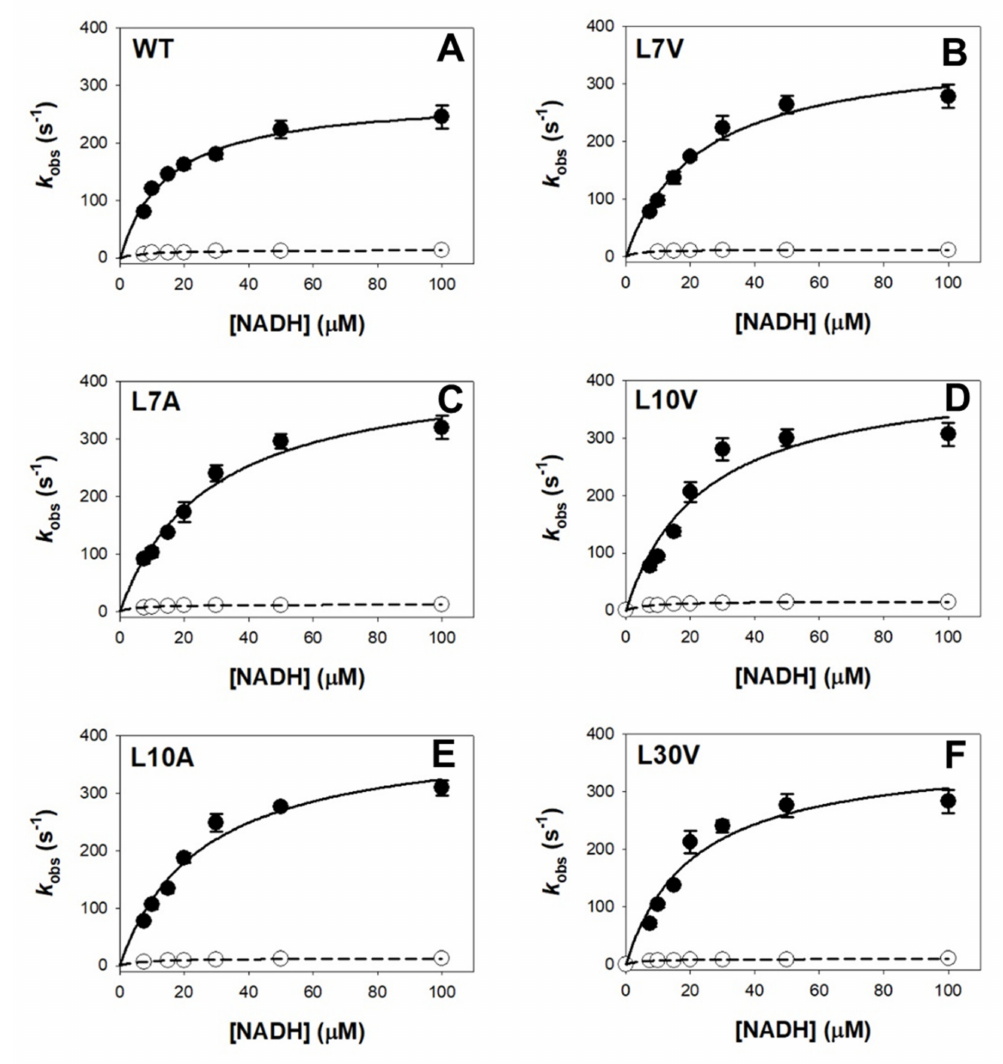
Figure 5. Dependence of k obs on NADH concentration for NQO1 variants. ( A – F ) Enzyme kinetics for different variants (the variant identity is displayed in each panel). Experiments were carried out using 7.5 µ M NQO1 at 6 ◦ C. Data are from at least three replicates and displayed as the mean ± s.d. Black circles correspond to the fast pathway, and open circles show data for the slow pathway. Lines are best fits to Equation (1). Each panel shows the data for the given